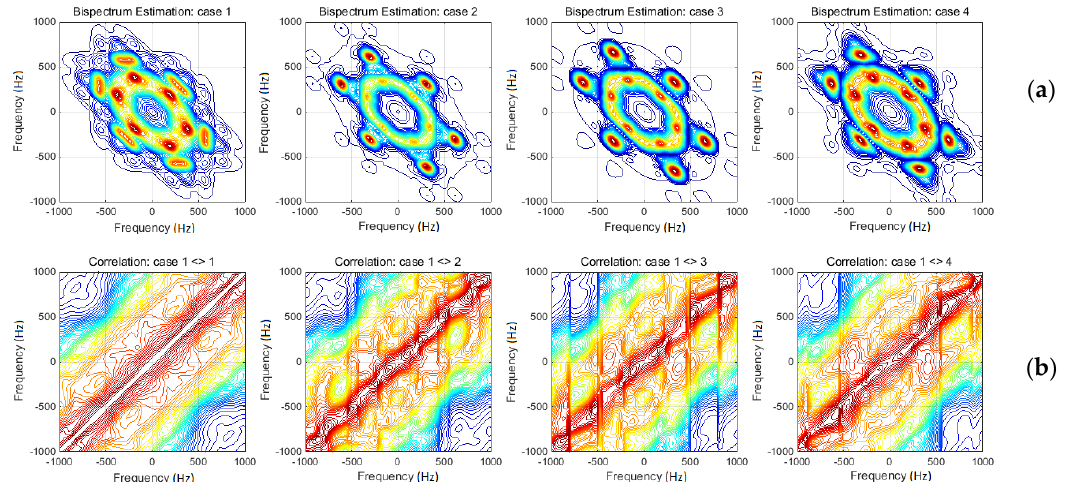
Figure 12. Bi-spectral analyses: ( a ) bi-spectrum diagrams for each considered cases; and ( b ) correlation coefficients between the first case and every other.